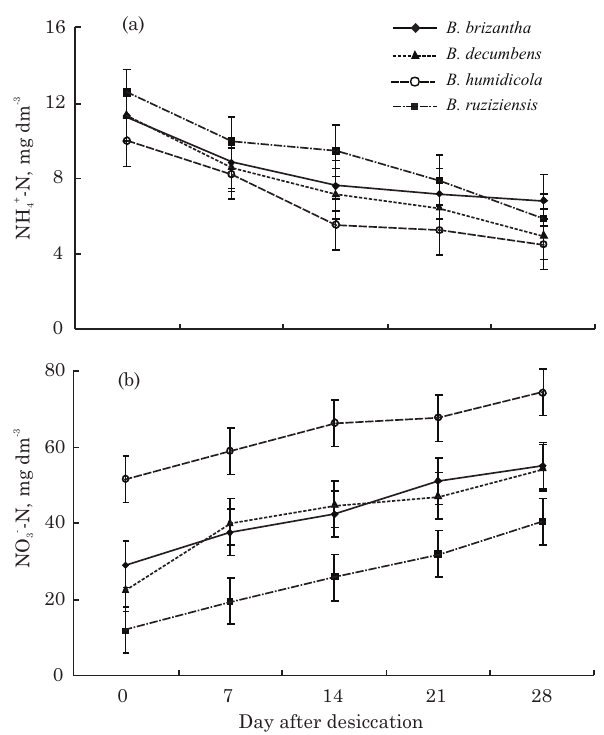
Figure 5. Ammonium (NH 4+ -N) (a) and nitrate (NO 3- - N) (b) in the soil after desiccation of B. brizantha , B. decumbens , B. humidicola and B. ruziziensis with glyphosate (mean of rhizosphere and non- rhizosphere soil). Vertical bars indicate the SDM from the t test (LSD) at 5